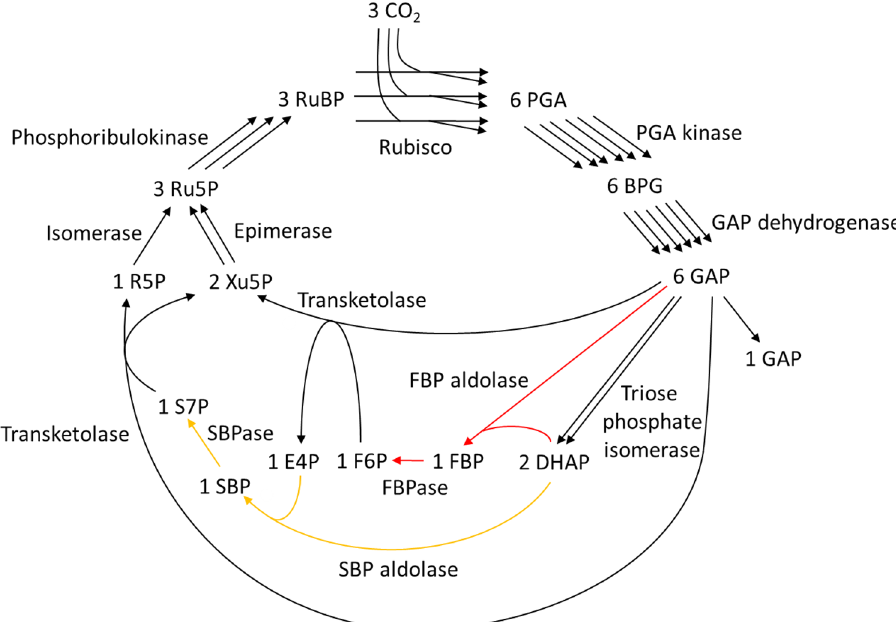
Figure 2. GAP formation from CO 2 through the canonical Calvin–Benson cycle. The reactions corresponding to the red arrows appear in the S7P-forming transaldolase variant, but not in the S7P-removing transaldolase variant. The reactions corresponding to the orange arrows appear in the S7P-removing transaldolase variant, but not in the S7P-forming transaldolase variant. For abbreviations, the meaning of the numbers before each metabolite, and currency metabolites, please see the legend in Fig. 1. In this paper, the FBP and SBP formation reactions catalyzed by aldolase are named FBP aldolase and SBP aldolase, respectively.